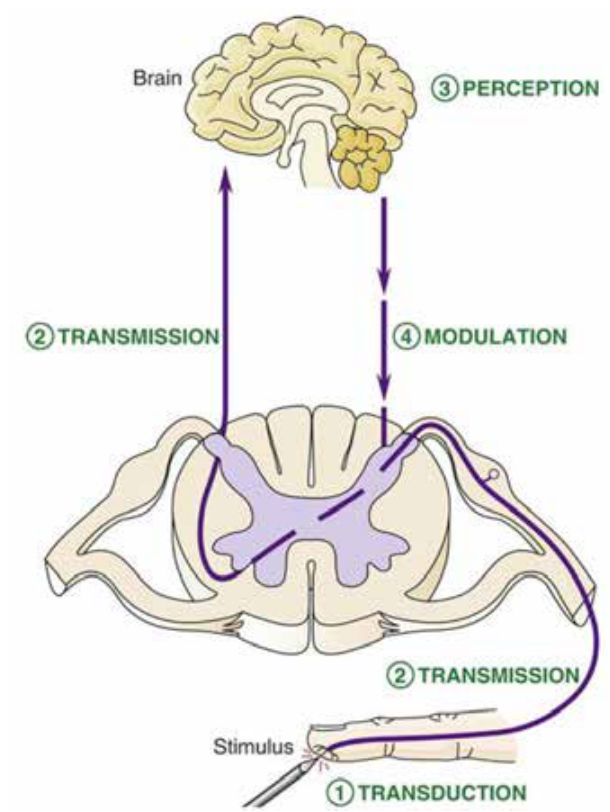
Figure 1: Nociceptive and pain pathways